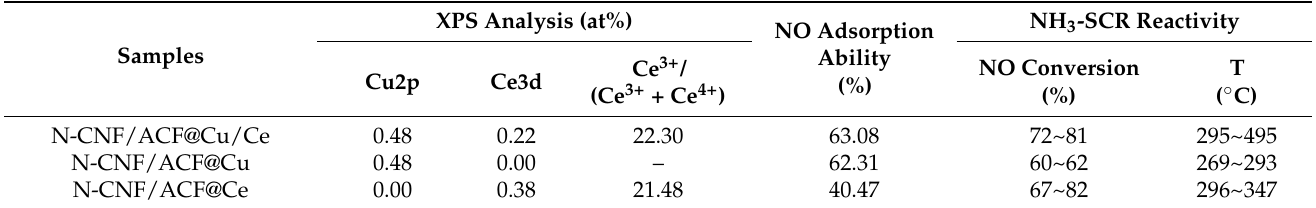
Table 1. XPS results, NO adsorption ability and NH 3 -SCR reactivity of N-CNF/ACF@Me.